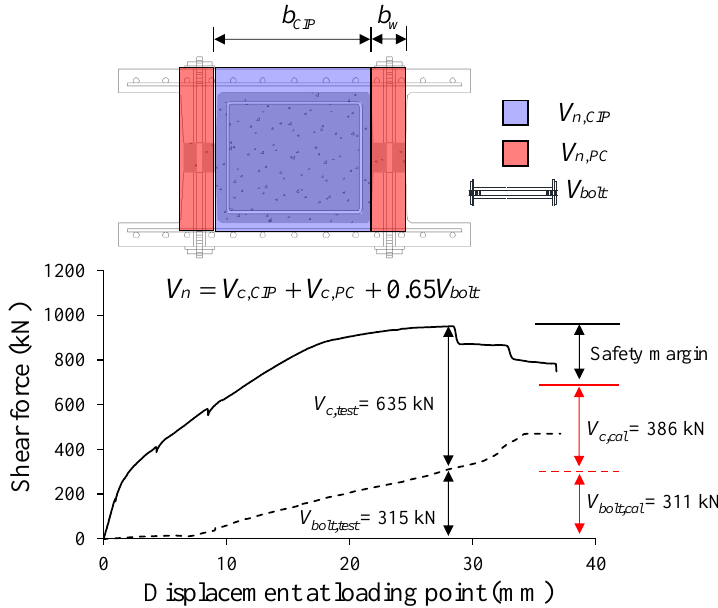
Figure 13. Shear strength estimation methods for DCW.